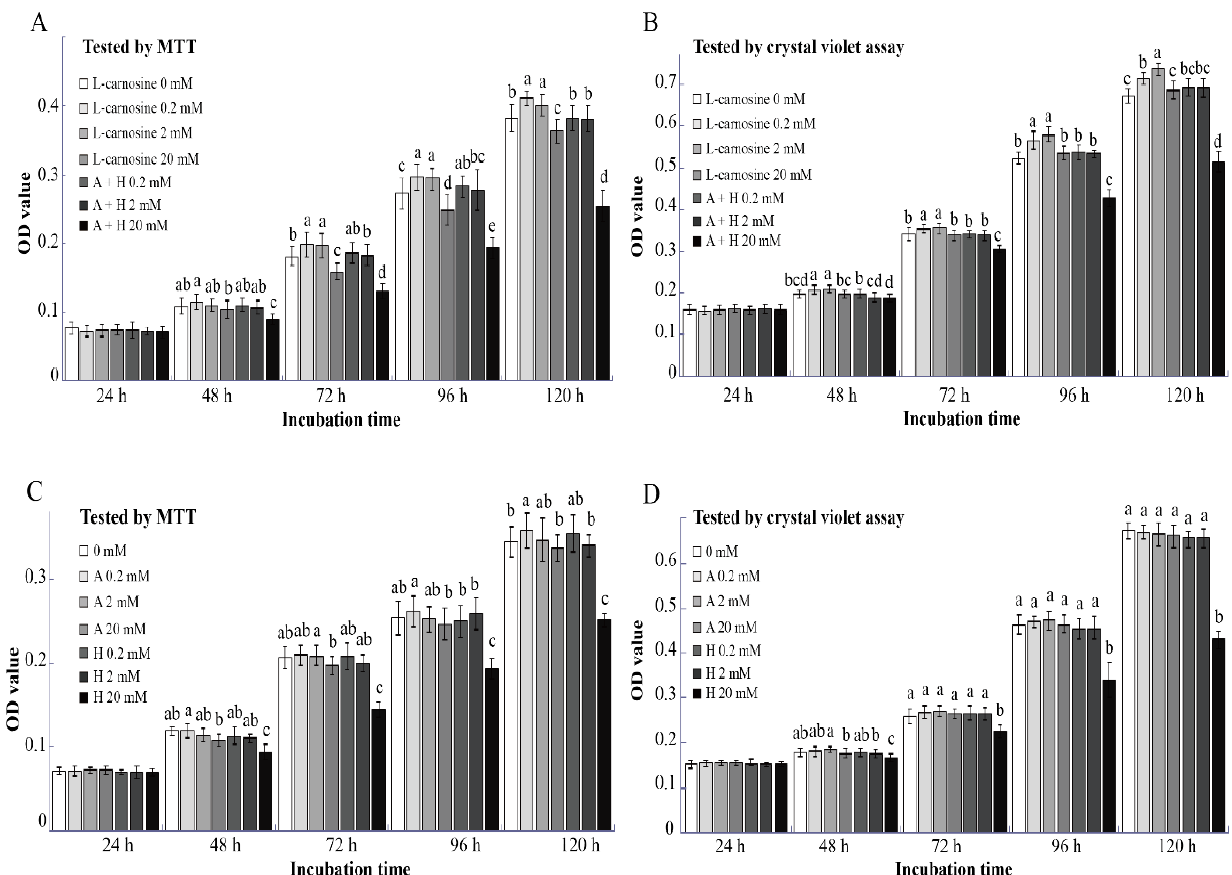
Figure 3. Effect of L-carnosine constituents on the proliferation of SCs in vitro ( n = 12). The effect of L-carnosine and the combination of β -alanine and L-histidine on SC proliferation ( A , B ). The effect of β -alanine and L-histidine on SC proliferation ( C , D ). MTT, 3-(4,5-dimethylthiazol-2-yl)-2,5-diphenyltetrazolium bromide; A, β -alanine; H, L-histidine; L-carnosine (0, 0.2, 2, and 20 mM), growth medium supplemented with different concentrations of L-carnosine (0, 0.2, 2, and 20 mM); A+H (0.2, 2 and 20 mM), growth medium supplemented with different concentrations of β -alanine and L-histidine (0.2, 2, and 20 mM); 0 mM, growth medium without β -alanine and L-histidine; A (0.2, 2, and 20 mM), growth medium supplemented with different concentrations of β -alanine (0.2, 2, and 20 mM); H (0.2, 2, and 20 mM), growth medium supplemented with different concentrations of L-histidine (0.2, 2, and 20 mM). Data are expressed as mean values ± SD. Means with different superscript letters (a–e) indicate significant differences at p <